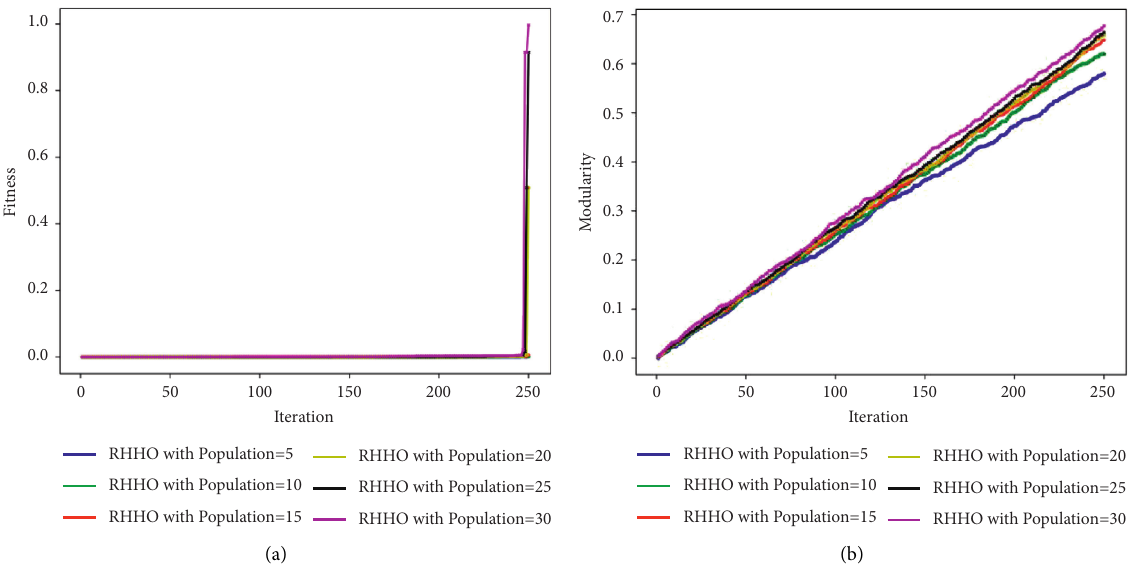
Figure 7: Performance analysis of proposed RHHO method using the American Revolution considering (a) fitness and (b)